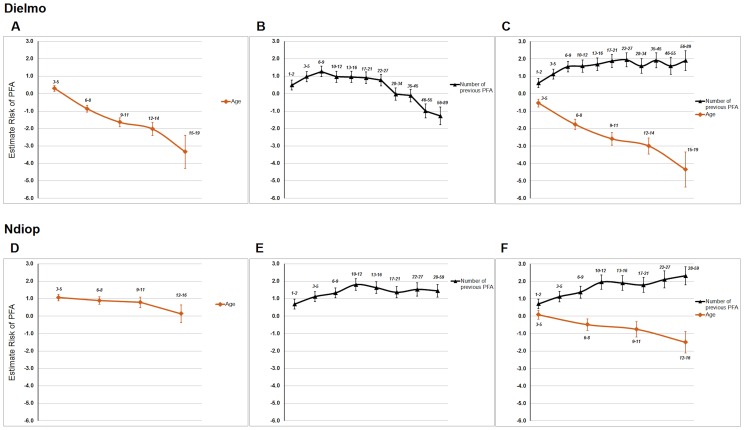
Estimated effects (beta coefficients) of having at least one P. falciparum clinical episode during the trimester in different models.These estimated effects were calculated in either Dielmo village (A to C) or Ndiop village (D to F) for “Age” alone (A and D), “Number of previous PFA” alone (B and E), and both variables (C and F).